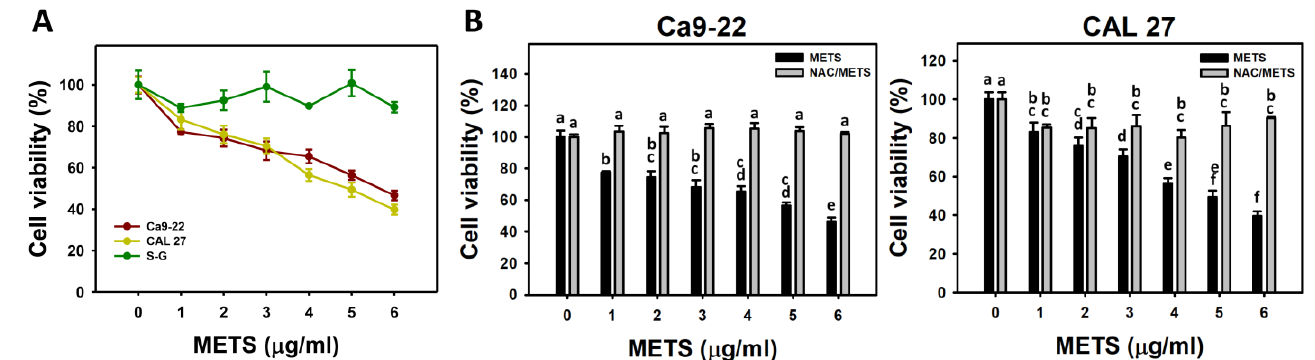
Figure 2. METS causes antiproliferation of oral cancer cells. ( A ) Cell viability. Cells were treated with METS for 24 h. Oral cancer (Ca9-22 and CAL 27) and normal cells (S-G) were included. ( B ) NAC response on cell viability of METS treatment. Untreated control and NAC pretreatment were followed by posttreatment of vehicle control (0 μg/mL) and METS (1, 2 ,3, 4, 5, and 6 μg /mL) for 24 h, i.e., control, NAC, METS, and NAC/METS, respectively. Data = mean ± SD ( n = 3). Data showing non-overlapping lower-case letters have significant results ( p < 0.05) as analyzed using the one-way ANOVA analysis and post hoc test. In the example of Figure 1B (Ca9-22 cells), the lower-case letters for METS at 0, 1, 4, and 6 μg /mL are “a, b, cd, and e”, revealing significant differences between each other. By contrast, the lower- case letters for METS at 1, 2, and 3 μg /mL are “b, bc, and bc”, indicating non- significant differences since they overlap with the same letter “b”.